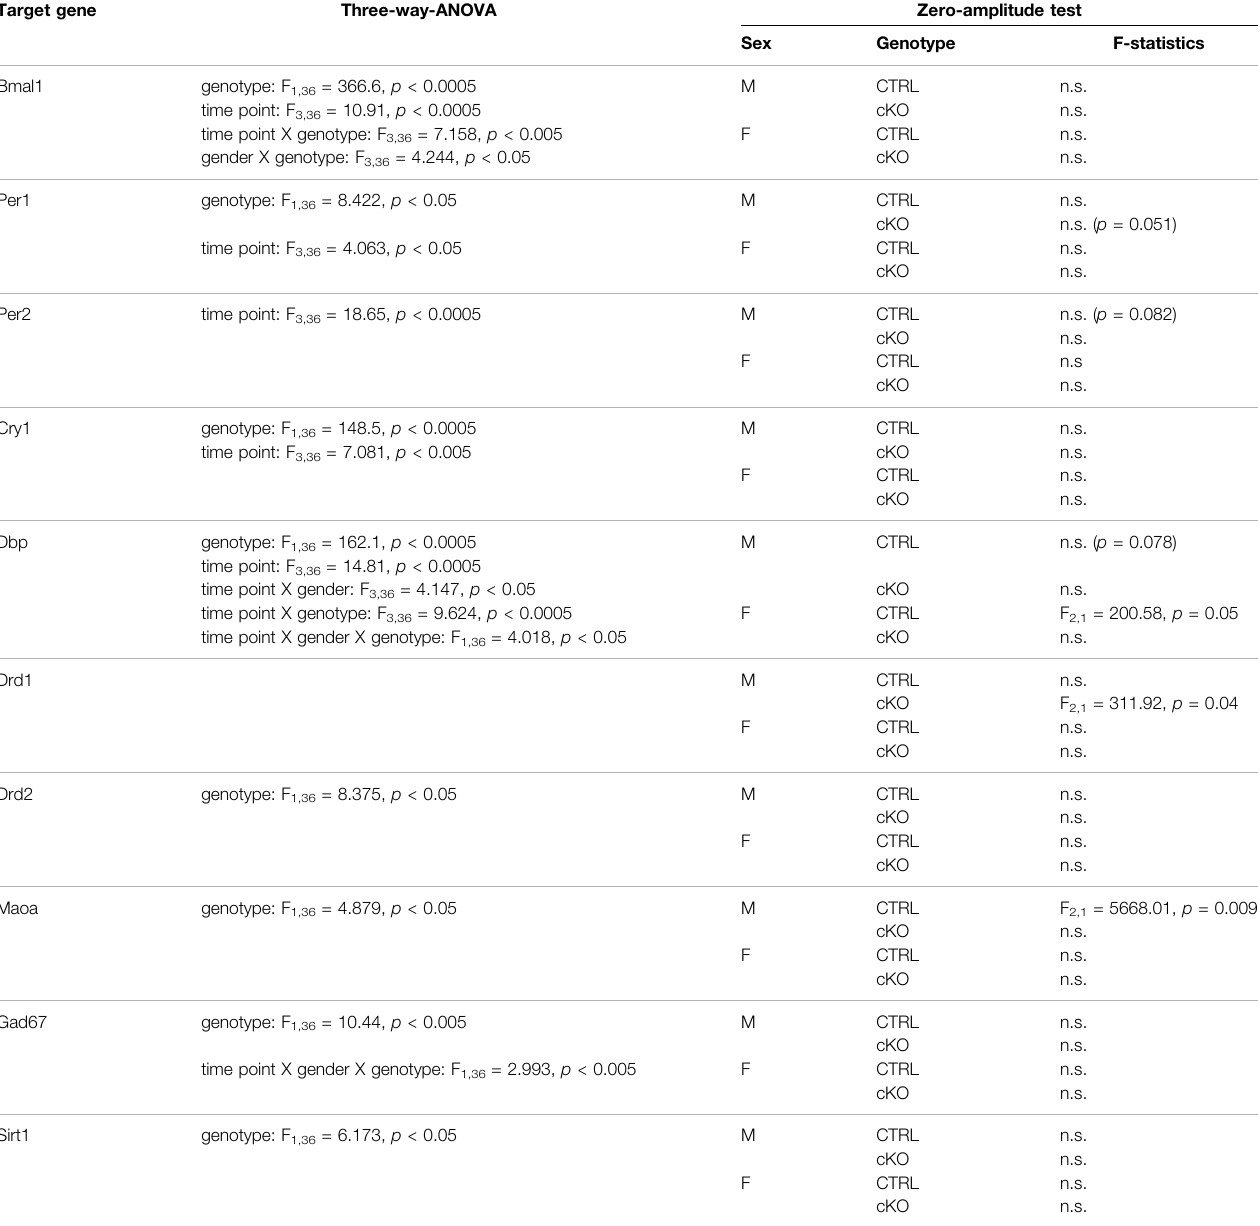
TABLE 4 | Results of the gene expression analysis. Target gene